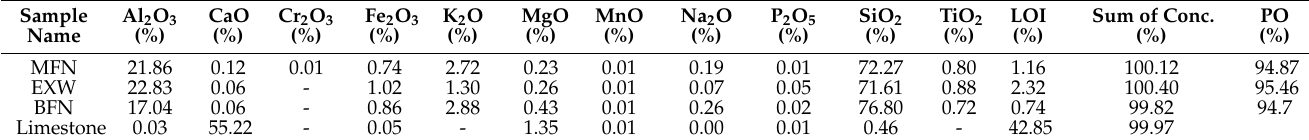
Table 4. Oxide compositions of the calcined clay samples and limestone.